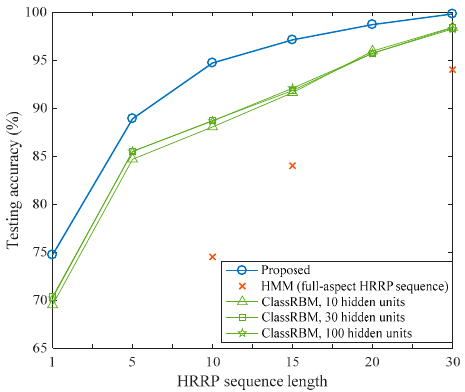
Table 2. Confusion matrix of the best model ( L = 15) for three targets problem. Figure 4. Recognition performance on models trained with different sequence length data. The result of HMM is provided by [20] in which a full-aspect HMM containing 55 states (aspect frames) was trained.